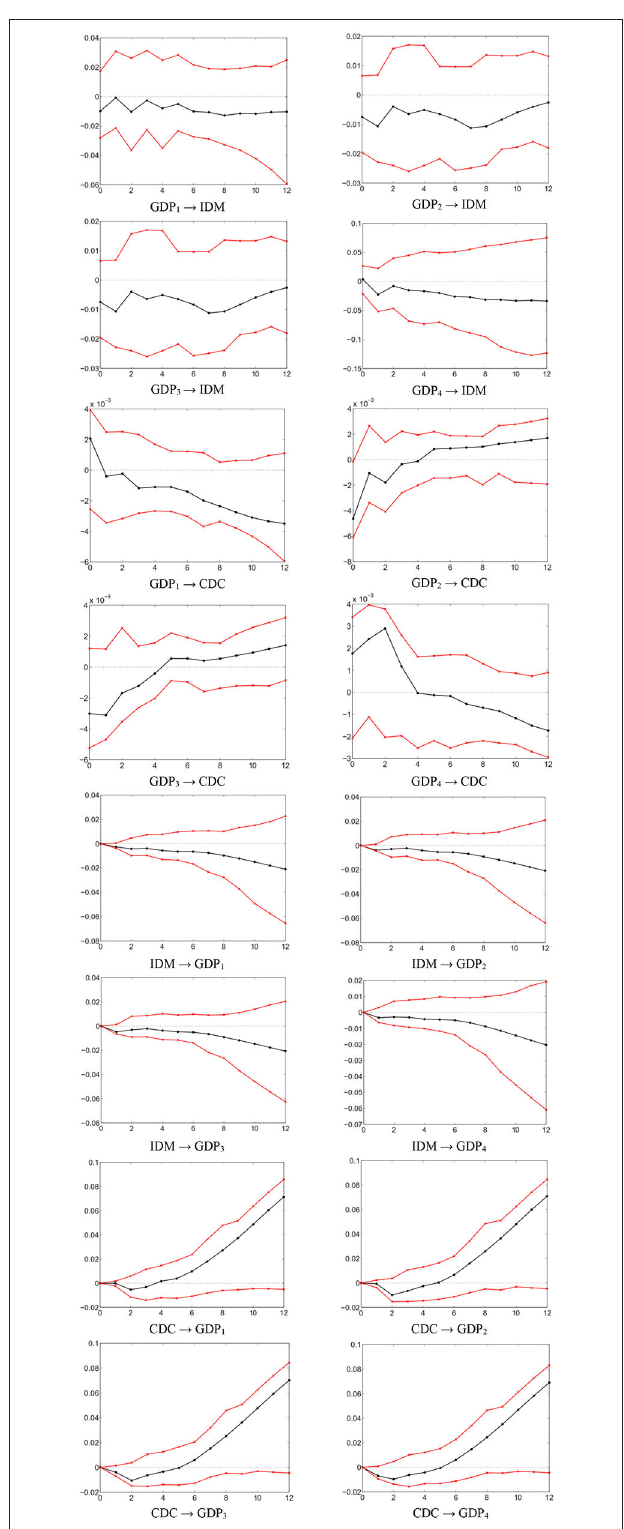
FIGURE 3 | Impulse response functions based on MF-VAR